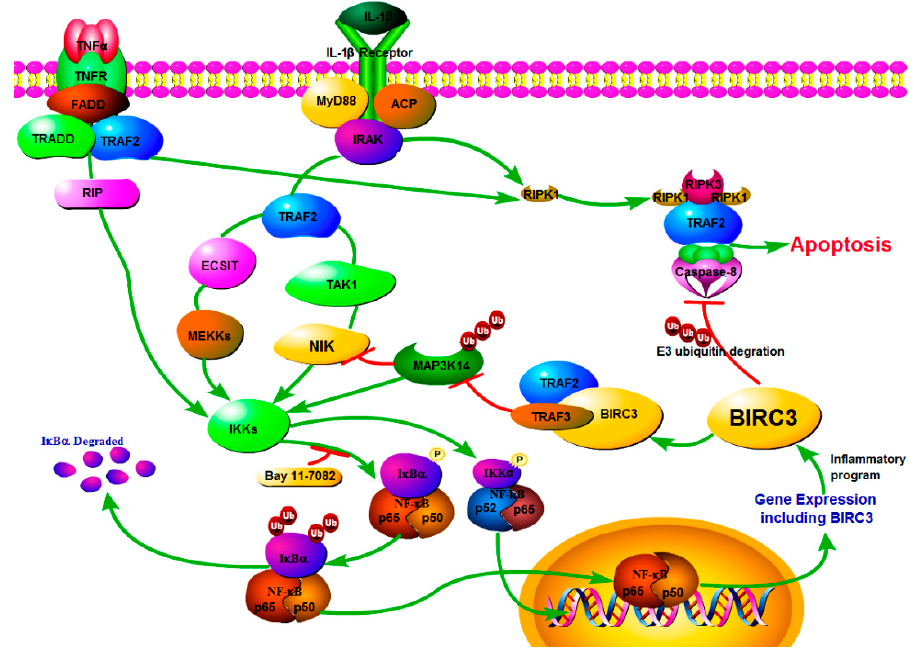
Figure 6. Putative BIRC3 roles in the NF- κ B pathway regulated by TNF α and IL-1 β in esophageal cancer cells. The pathway map was constructed by Pathway Builder Tool 2.0.